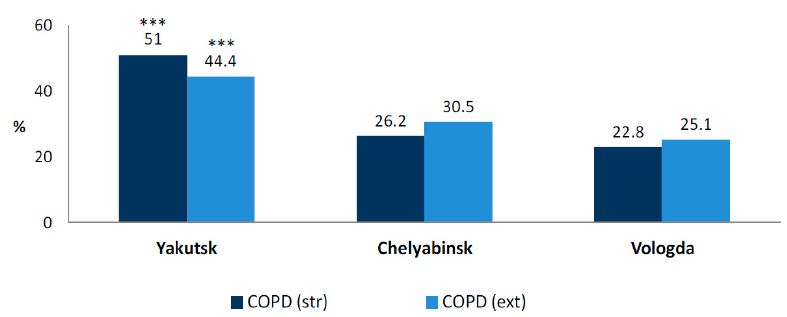
Figure 4. Prevalence of chronic obstructive pulmonary disease in the studied regions. *** p < 0.0001.